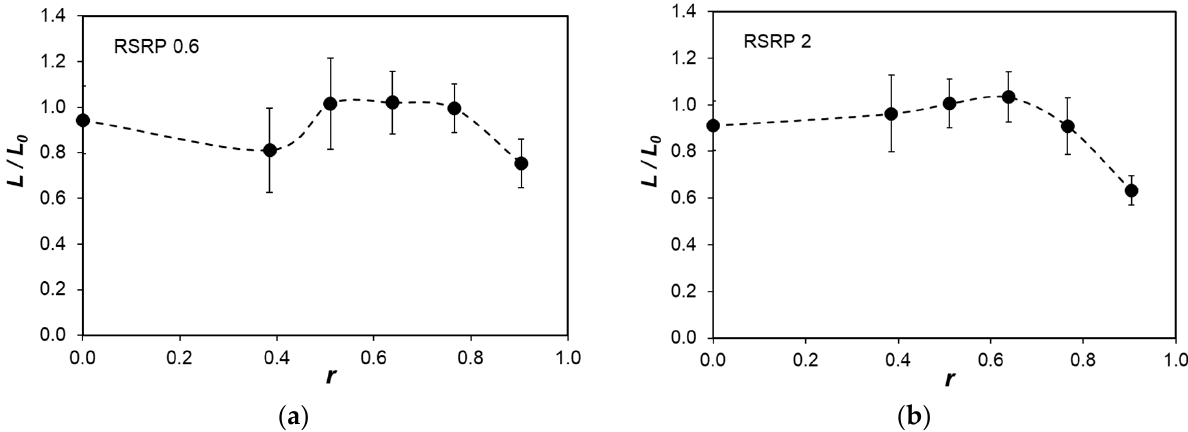
Figure 5. Relative local superficial velocity (collection sections 1–6, Table 1) in uniform initial distribution, L 0 = 3 · 10 − 3 m 3 m − 2 s − 1 , L 0 = 7 · 10 − 3 m 3 m − 2 s − 1 , L 0 = 12 · 10 − 3 m 3 m − 2 s − 1 : ( a ) plastic Raschig Super–Ring 0.6; ( b ) plastic Raschig Super–Ring 2.